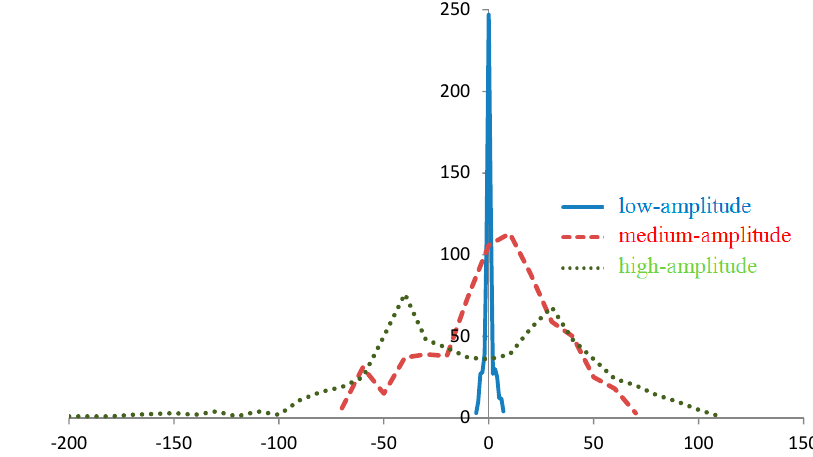
Figure 1. Distribution of points by |𝑔̅| for regions with low-amplitude, medium-amplitude, and high-amplitude gravity anomalies, mGal.